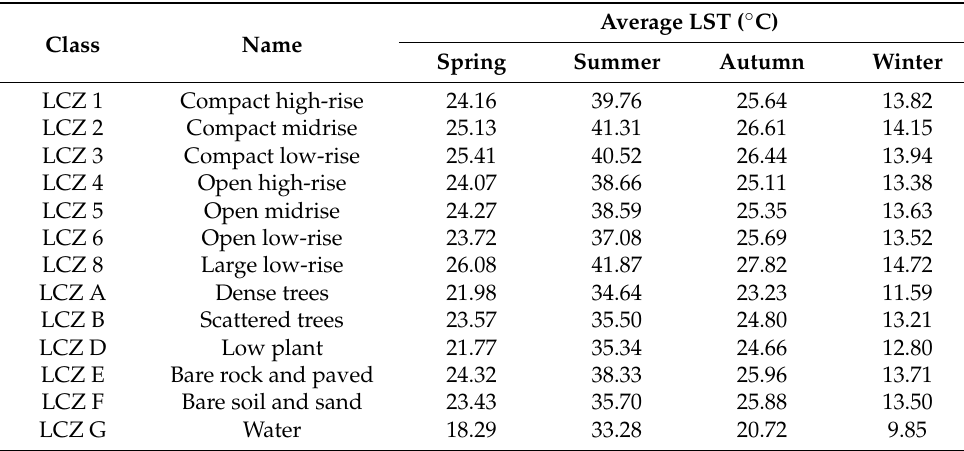
Figure 4. Seasonal LST maps of Wuhan. Table 3. The average LST results of local climate zones in each season.